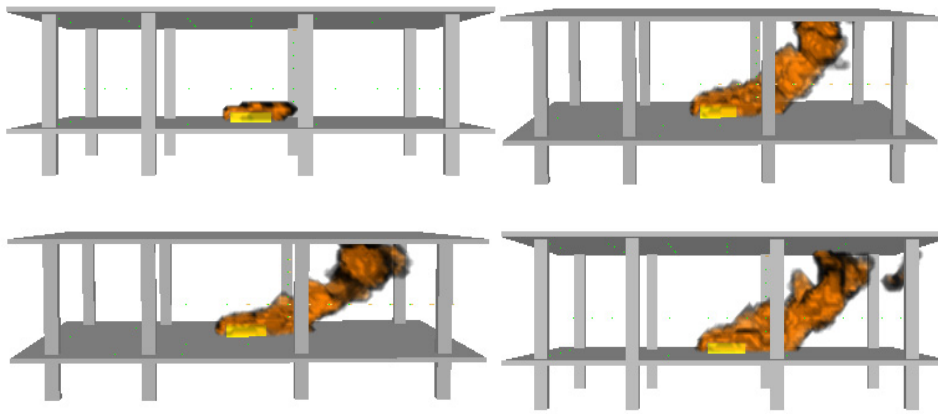
Figure 10. Flame shapes under the wind speed of 3 m/s.